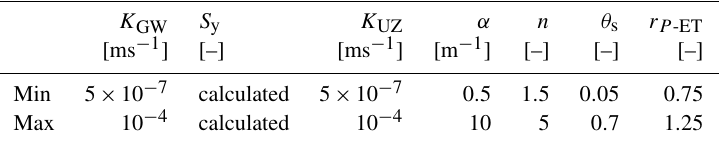
Table 3. Parameter ranges for the parameters included in the sensitivity analysis. For the saturated hydraulic conductivity, values for the groundwater (GW) and the unsaturated zone (UZ) model as well as the van Genuchten α the normal logarithm are sampled.